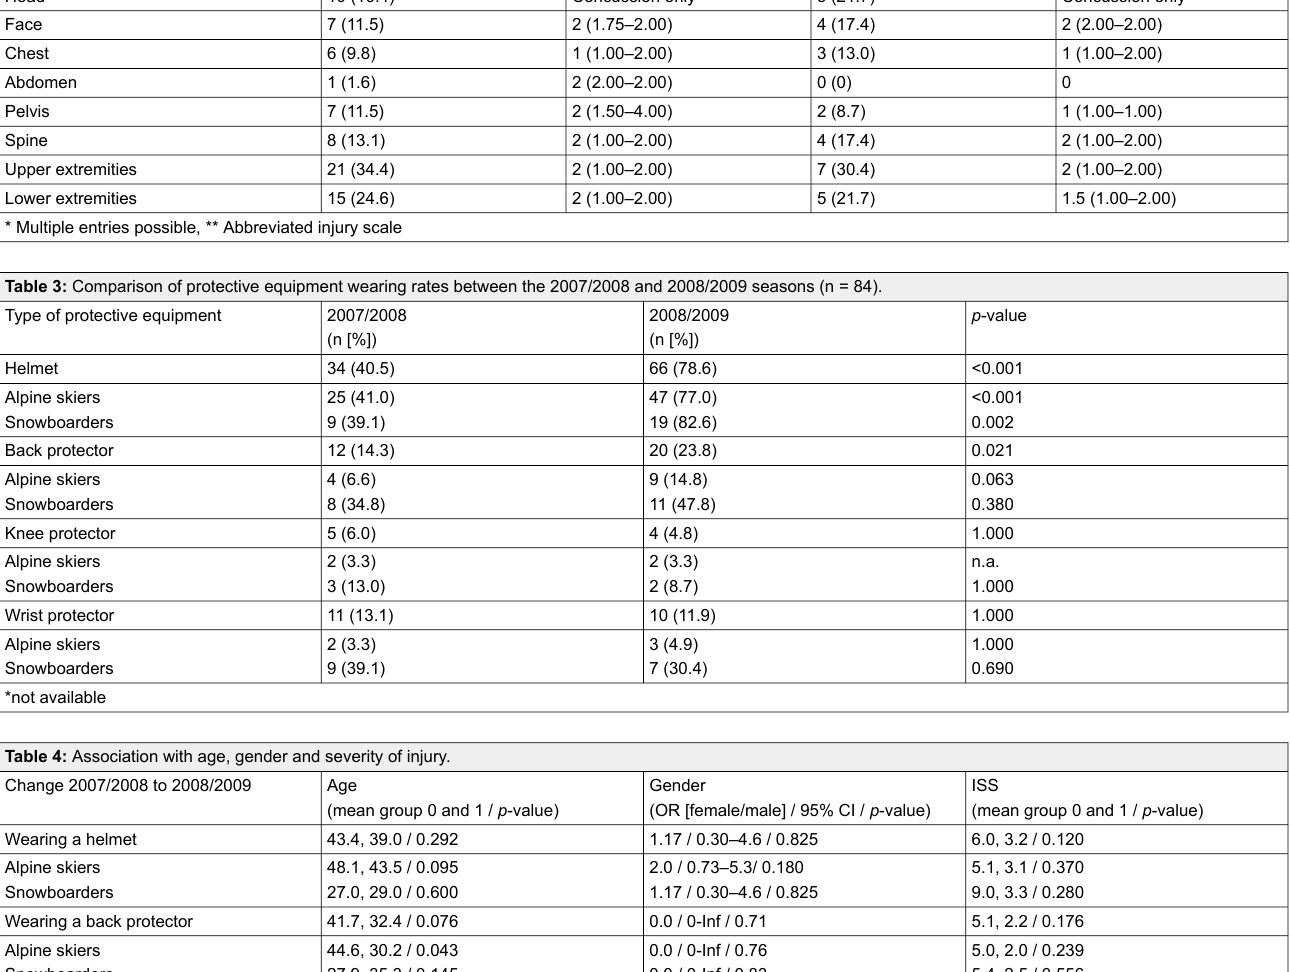
Table 2: Injured body regions of included patients (n = 84). Body region*